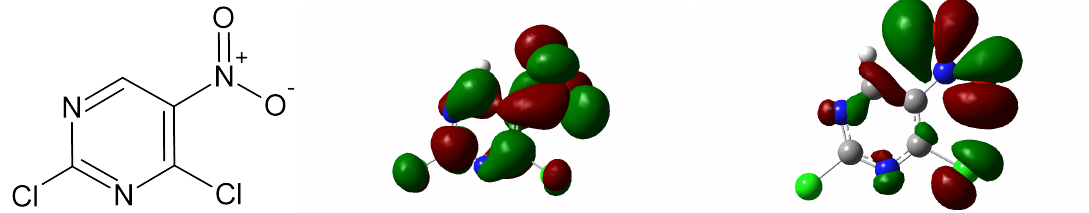
Figure 1. Sketch of neutral 5-nitro-2,4-dichloropyrimidine structure ( left ), its Lowest unoccupied orbital ( center ), and Highest occupied orbital of anion ( right ) calculated at DFT B3LYP/6-31G+(d) level of theory in Gaussian